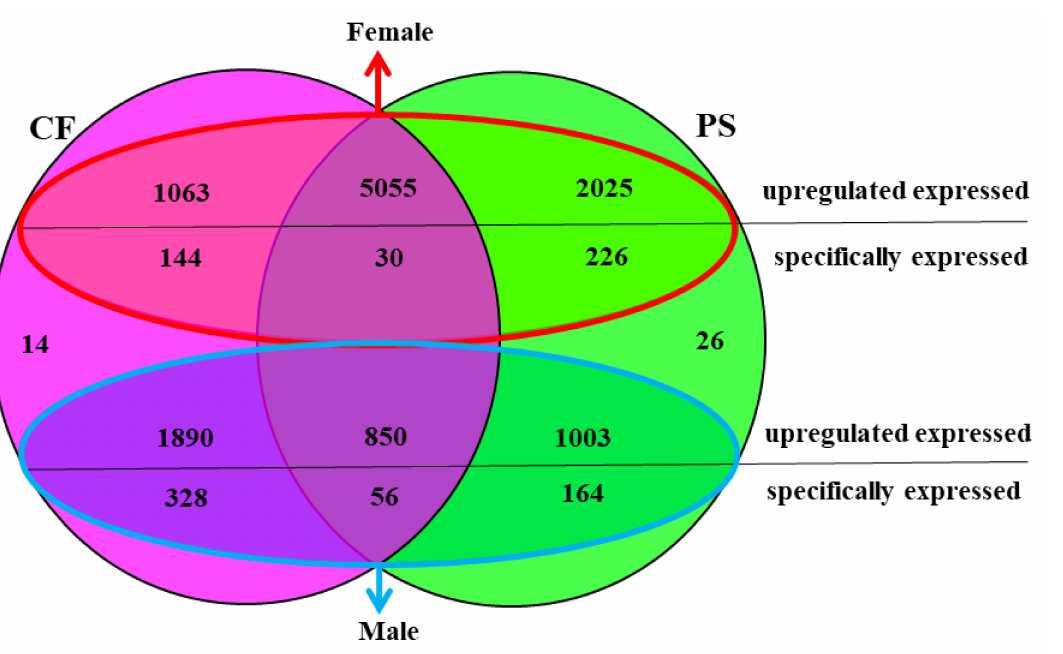
Figure 5. A Venn diagram showing the number of unigenes comparing PS vs. CF. The circle with the red border refers to the females and the blue refers to the males. PS represents Portunus sanguinolentus and CF represents Charybdis feriatus . The numbers of the unigenes represent all the new unigenes detected in the present